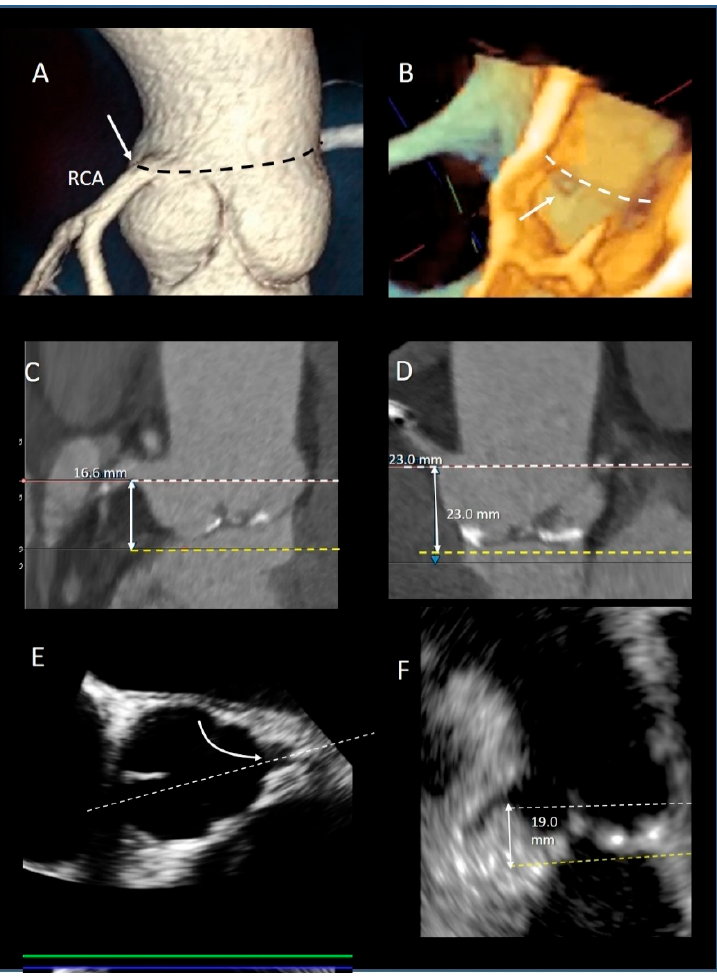
Figure 10. ( A ) CT Volume rendering modality showing the origin of right coronary artery arise at the level of sinutubular junction (black dotted line). ( B ) The 3D TEE longitudinal cross-section showing the orifice of coronary artery (arrow) at level of sinutubular junction (white dotted line). ( C , D ) CT multiplanar image modality showing the measurements of the distance (double-headed arrow) between the coronary ostia (white dotted line) and the virtual annulus (yellow dotted line). ( E ) The 2D TEE multiplanar reconstruction derived by 3D data set in short-axis view of the aorta showing the orifice of LAD (curved arrow). The white dotted line indicates the longitudinal cross- section plane that shows the image of the panel. ( F ) From this image, the distance between the coronary ostia (white dotted line) and the virtual annulus (yellow dotted line) can be measured (double-headed arrows).